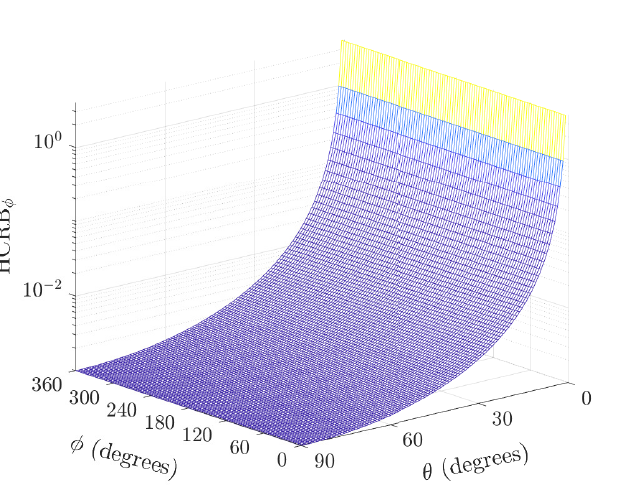
Figure 5. Plot of HCRB φ versus direction of arrival polar and azimuth angles for K = 100 samples, σ 2 s / σ 2 n = 5, and σ v = 0 (a perfectly perpendicular case).